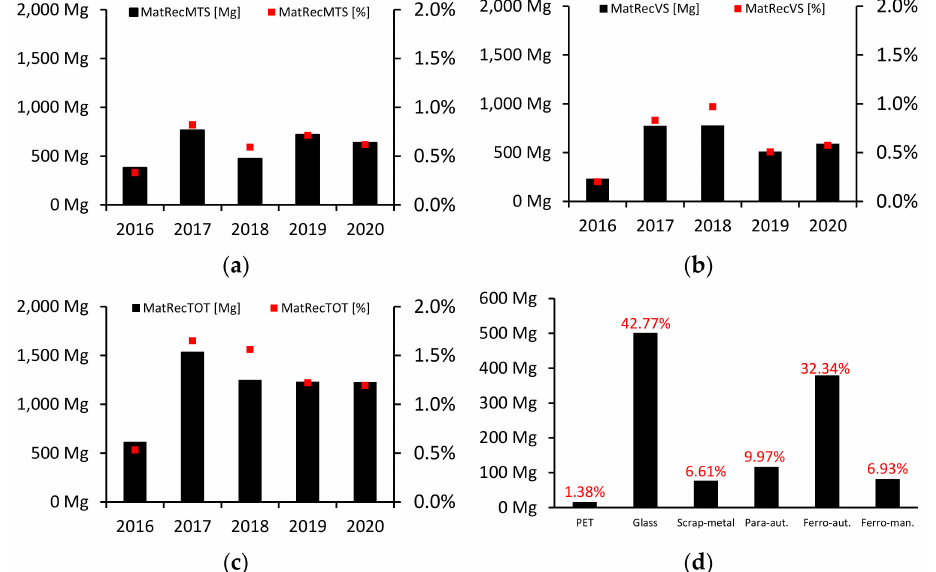
Figure 5. Technological flow of the Municipal Waste Management Plant in Olsztyn; ( a ) recovery of commercial assortments in the mechanical processing section; ( b ) recovery of commercial assortments in the valorization section; ( c ) recovery of commercial assortments in total; ( d ) average composition of segregated commercial assortments for